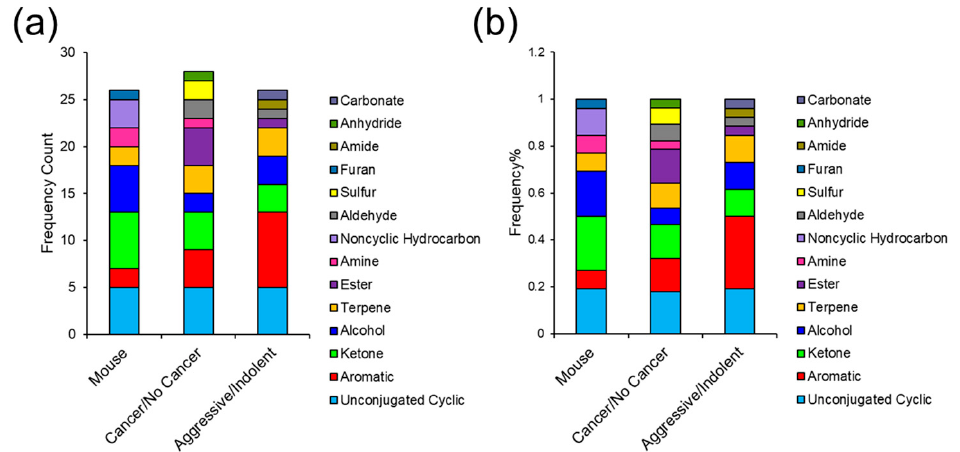
Figure 7. ( a ) Functional group frequency and ( b ) functional group frequency ratio of urinary VOCs identified to be differentially expressed ( p -value < 0.05) by prostate cancer in the mouse model and in humans. The same is also displayed for urinary VOCs in humans that were dysregulated by aggressive prostate cancer.